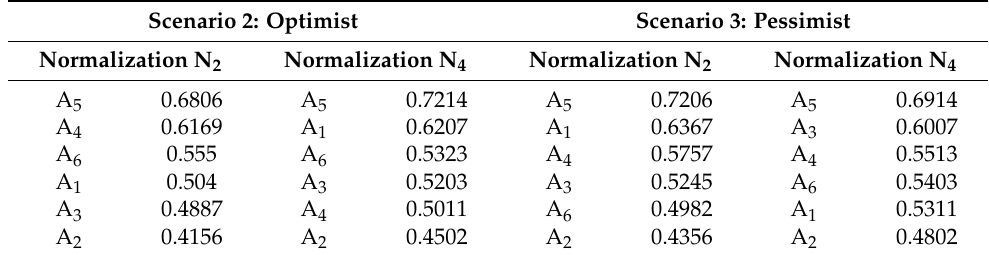
Table 16. Optimist and pessimist scenarios